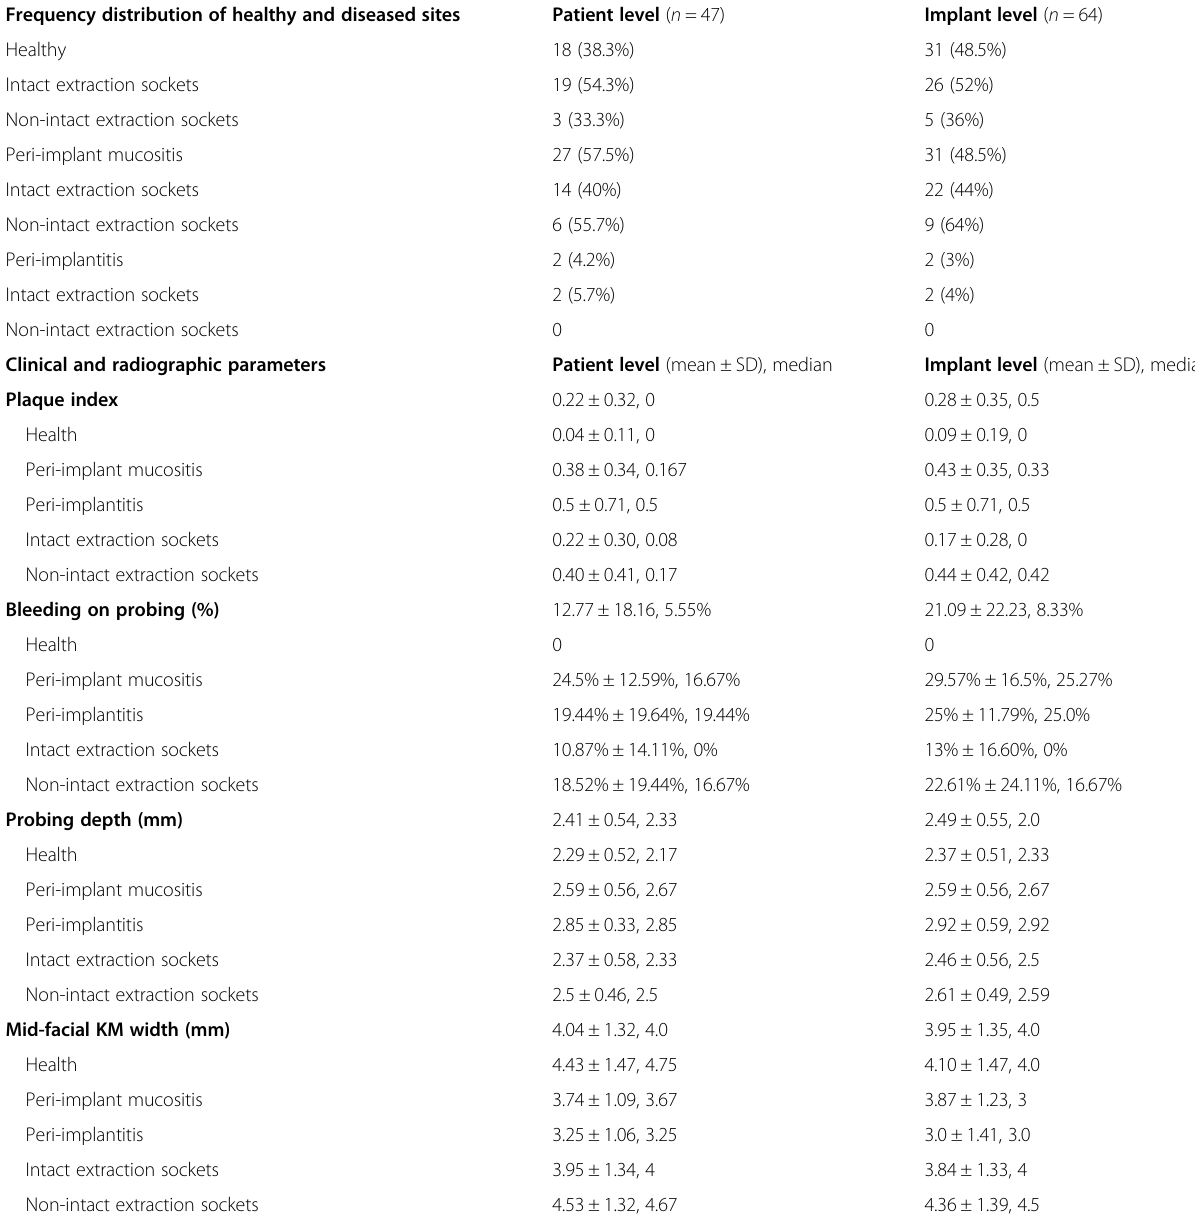
Table 4 (a) Prevalence of peri-implant tissue health and disease (i.e., peri-implant mucositis and peri-implantitis at patient and implant level; (b) clinical treatment outcomes in different patient/implant groups Frequency distribution of healthy and diseased